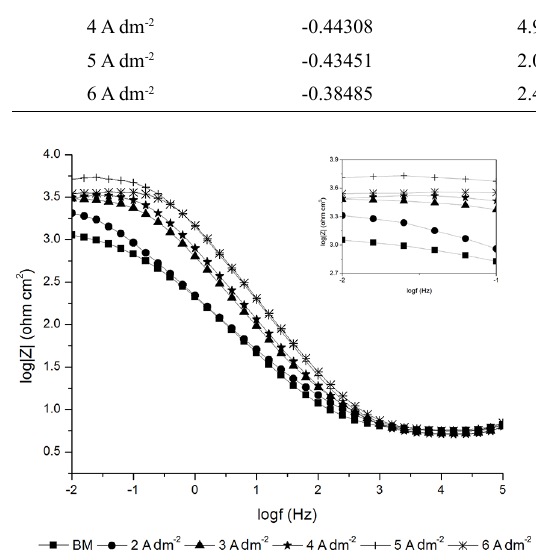
Figure 6. Bode (log|Z|) diagrams for Co-Ni/SiC nanocomposite coatings and base metal in a 3.5 wt.% NaCl solution.